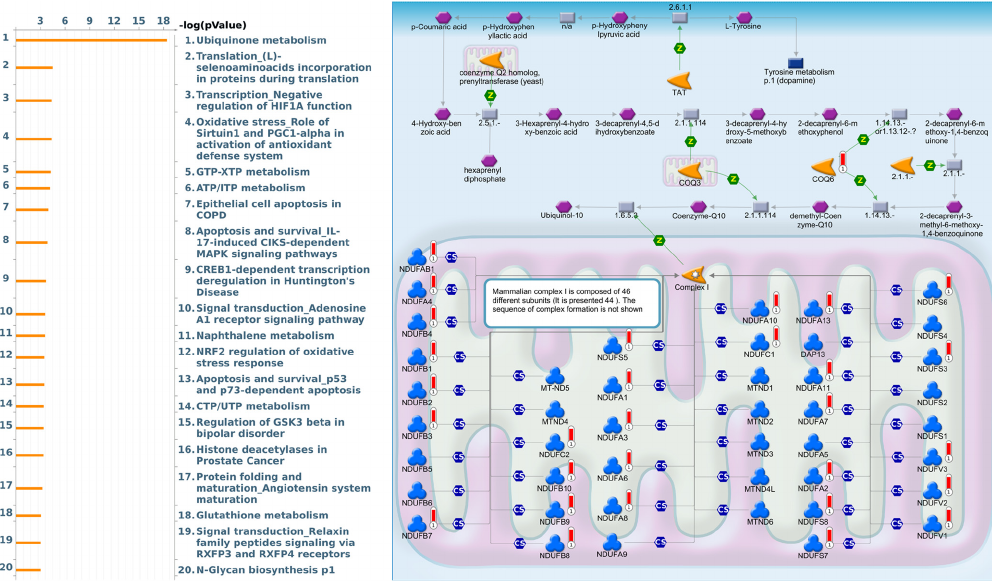
Figure 5. MetaCore pathway analysis of the coexpression gene network of FKBP family members in lung adenocarcinoma (LUAD) patients. The MetaCore pathway analysis of ʺ biological processes ʺ revealed that ʺ Ubiquinone metabolism ʺ‐ related pathways were correlated with LUAD development.